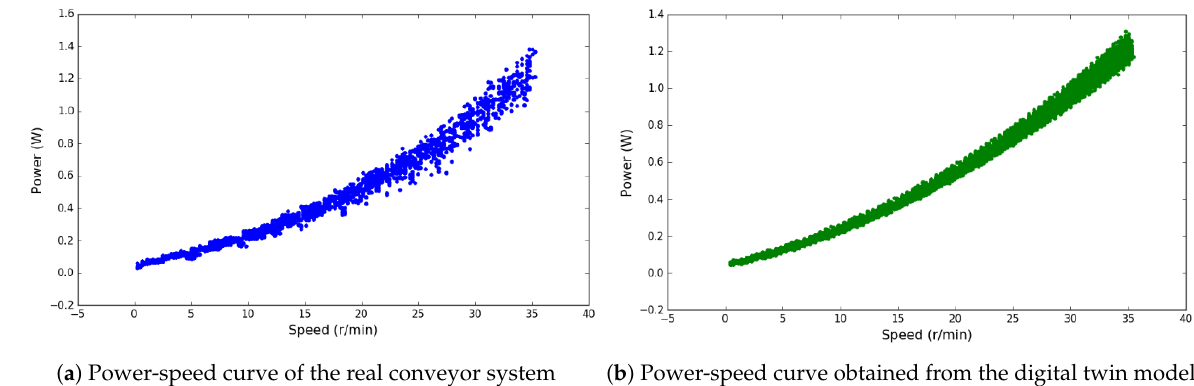
Figure 2. The fingerprint , i.e., nominal power-speed characteristics, of the system under various torque (load)